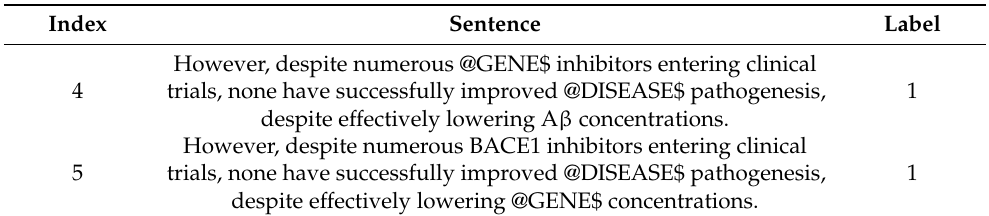
Table 1. RE input